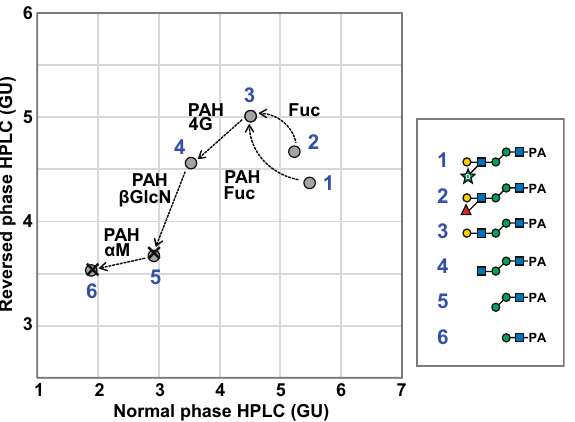
5 63 Normal phase HPLC (GU) Figure 4. Two-dimensional mapping of the pentose-containing N -glycan treated by partial acid hydrolysis or sequential enzymatic digestions. Elution positions of PA-glycans on normal phase- and reversed phase- HPLC are represented by glucose units (GU). Closed gray circles indicate the position of the pentose- containing PA-glycan or its products by partial acid hydrolysis (PAH) or sequential enzymatic digestions. No. 2 used as a standard was an enzymatic digestion product of triantennary N -glycan obtained from α1-acid glycoprotein. × marks the positions of the authentic standard compounds. Enzymes used for glycan structural analyses are abbreviated as follows: Fuc, α1,3/4-l-fucosidase; 4G, β4-d-Galactosidase; βGlcN, N -acetyl-β-d- glucosaminidase S; αM, α1,2/3/6-mannosidase. Symbol representations of glycans are as follows; galactose, yellow circle; mannose, green circle; GlcNAc, blue square; arabinose, green star; fucose, red